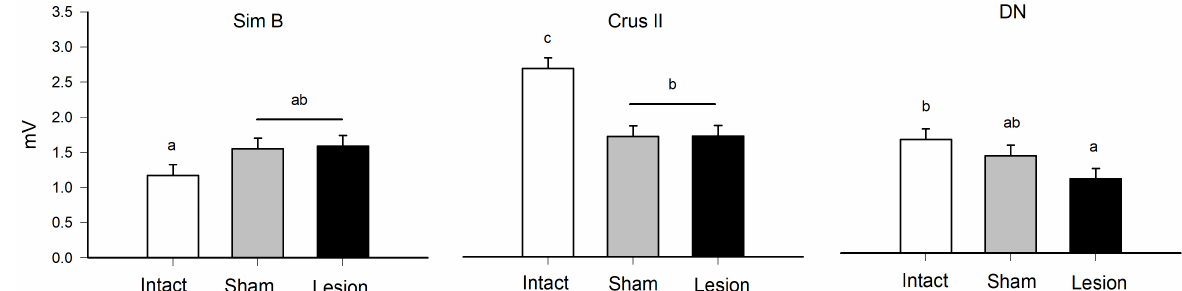
Figure 2. Mean value (mean ± SE) of the maximum amplitude (mV) during grooming behavior in Sim B, Crus II, and the dentate nucleus (DN) in the intact, sham, and lesion groups. The different letters on the bars (a, b, and c, α = 0.05) indicate contrast in multiple comparisons by Tukey’s method for the means recorded in the groups of rats and structure that were delimited by the effect of the interaction corresponding to the statistical model (Table 1). Table 1. Effects test for grooming behavior. Results of nested ANOVA for the effect of traces (T), rat (R), structure (S), group (G), and probability of differences based on F values and r 2 = 0.37 of the model. The animals used were made in independent groups.